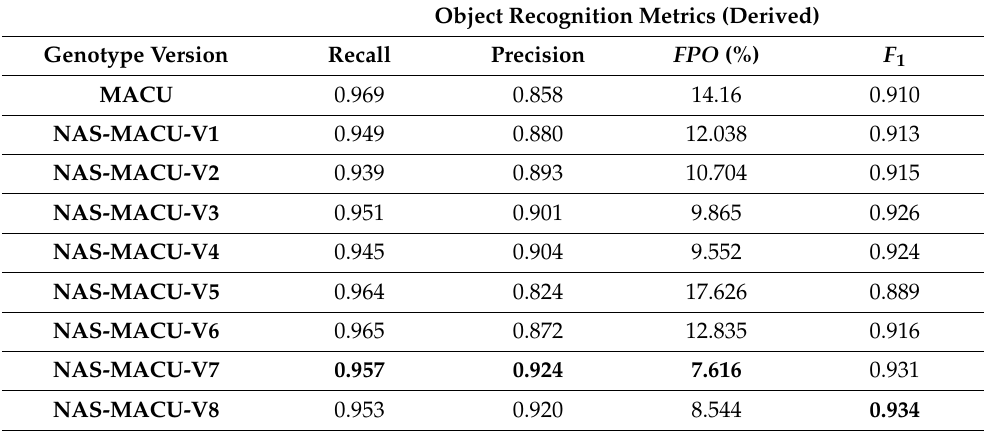
Table 5. Performance comparison by object recognition metrics (recall, precision, FPO , F 1 ) across genotypes.